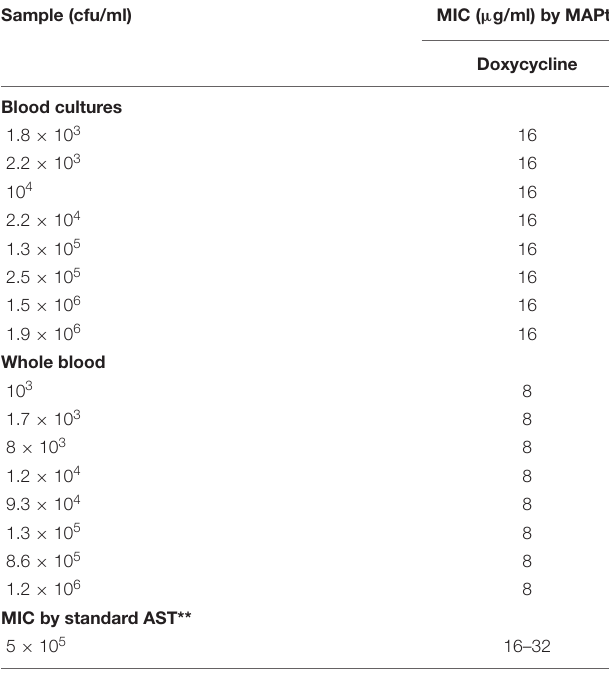
TABLE 5 | MIC values obtained by MAPt of whole blood samples inoculated with B. anthracis . Sample (cfu/ml) MIC ( µ g/ml) by MAPt*